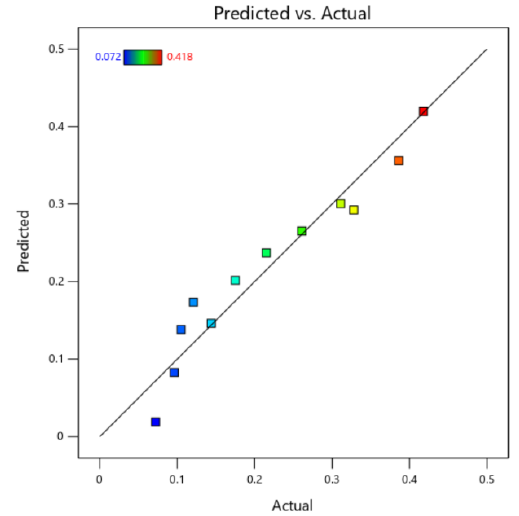
Figure 3. Predicted versus actual values for the CCD model.